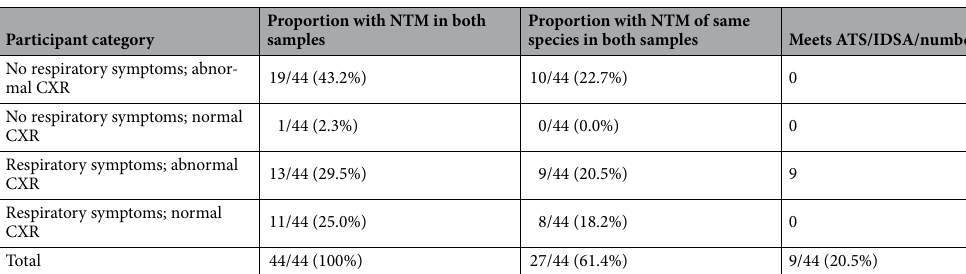
Table 6. The distribution of American Thoracic Society/Infectious Disease Society of America defined clinically relevant NTM by participant categories.